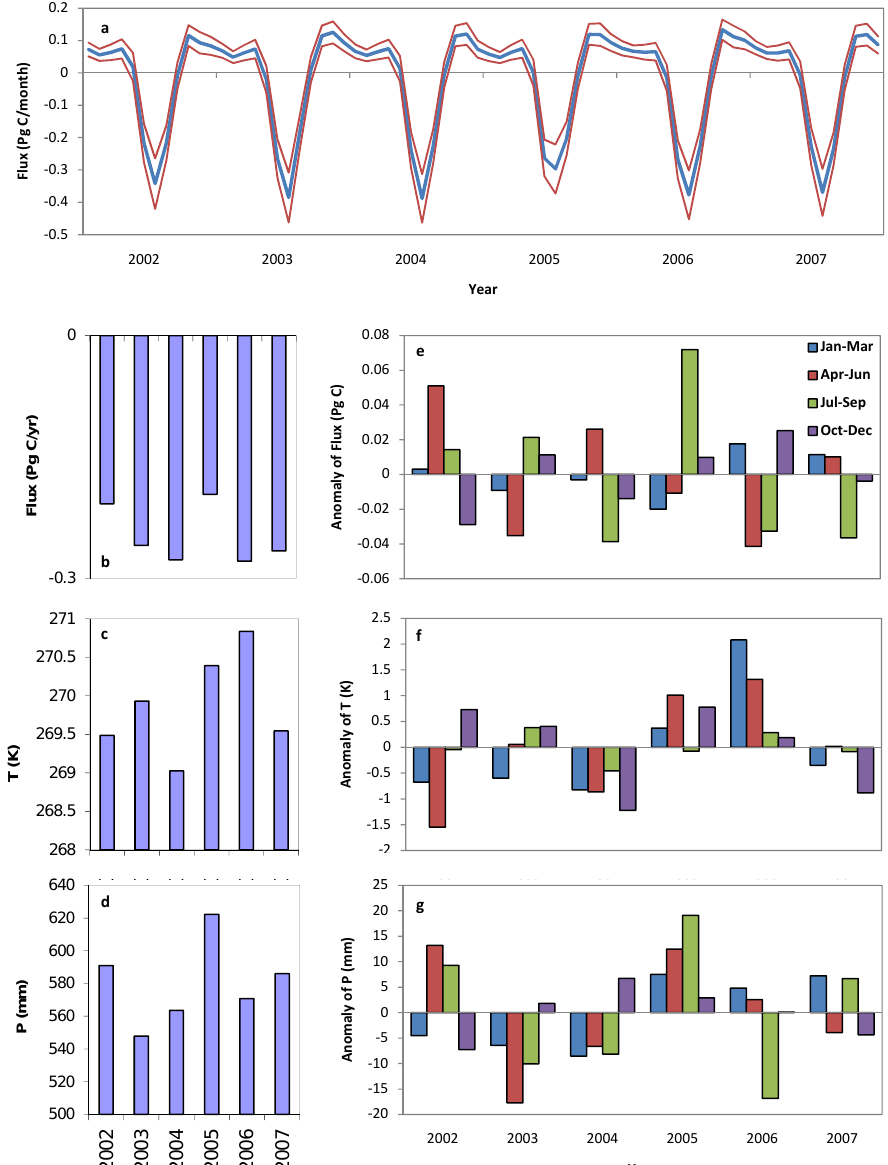
Fig. 6. The variations of inverted fluxes and climatic conditions from 2002 to 2007 in Region NA-N (Regions 1–17). (a) The inverted monthly fluxes (thick blue line) and their uncertainties (thin red line), (b) the inverted annual fluxes, (c) the annual mean temperatures, (d) the annual precipitations, (e) the 3-monthly anomalies of inverted fluxes, (f) the 3-monthly temperature anomalies, and (g) the 3-monthly precipitation